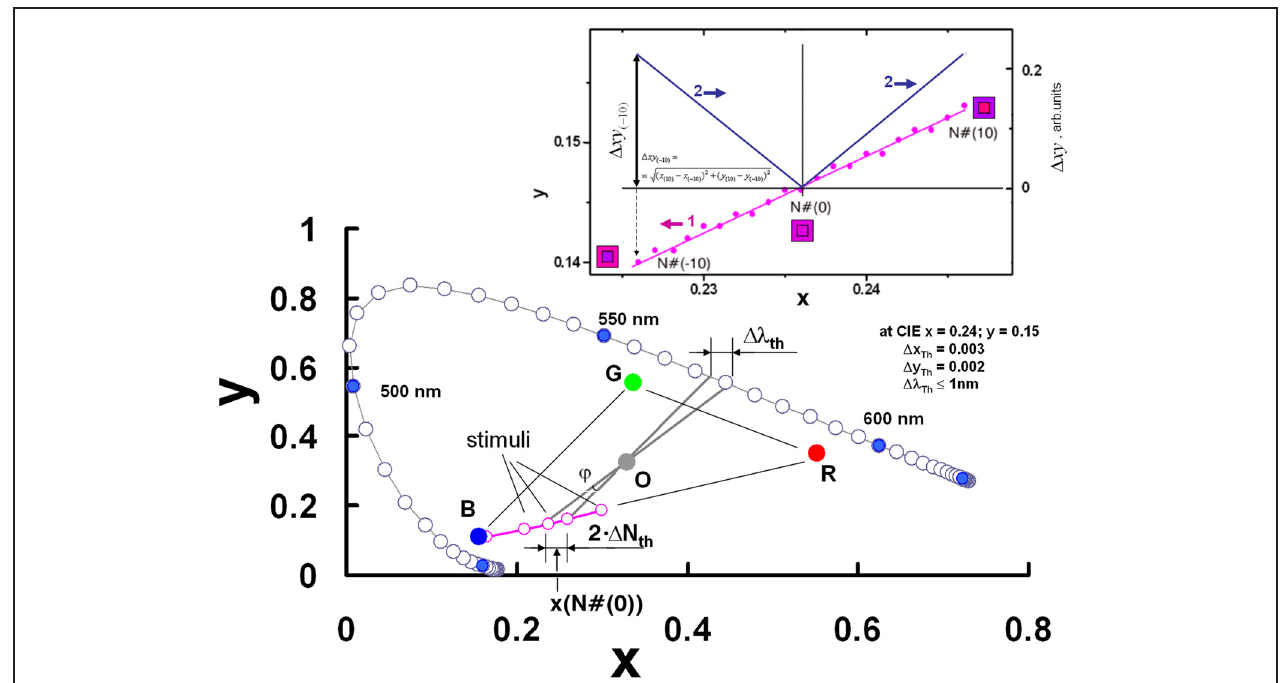
FIGURE 4 | Schematical presentation of the trial stimuli in CIE xy chart – its central part chromaticity coordinates, and the principles of recalculation of the color difference threshold in the complimentary wavelength metrics. In the upper right corner